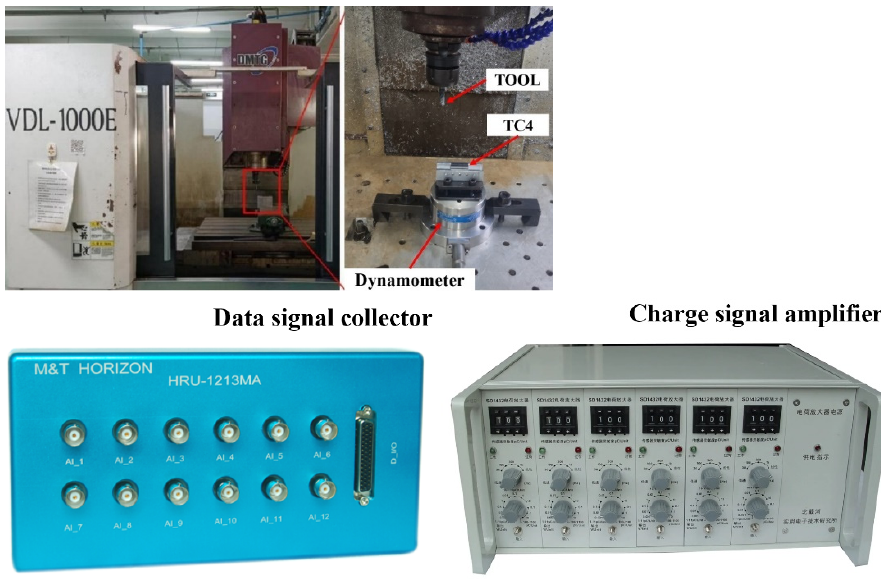
Figure 1. The samples and the experimental equipment used in the milling experiment. Table 1. The main chemical composition of Ti-6Al-4V.